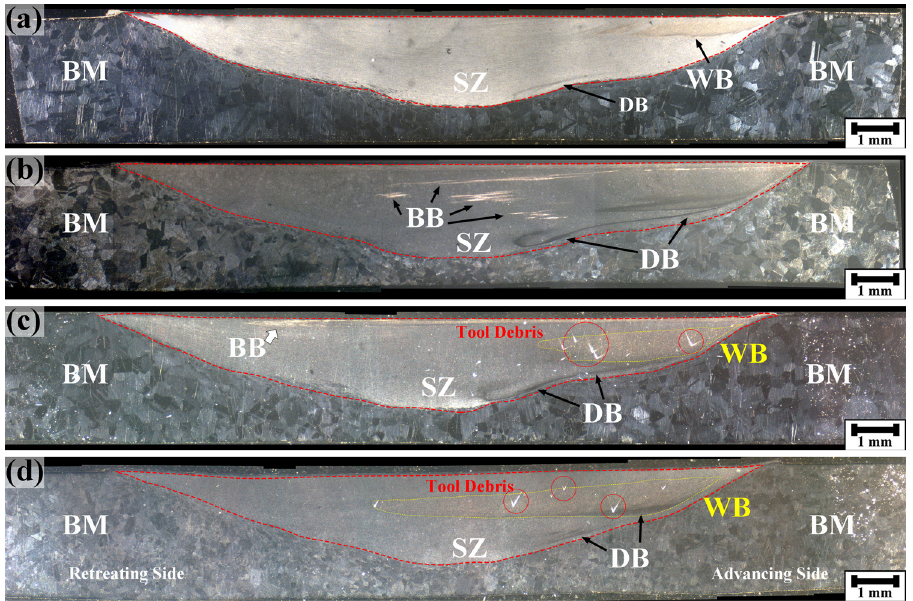
Figure 5: Cross - sectional macrostructure of the welds at rotational speed of ( a ) 200, ( b ) 300, ( c ) 400, and ( d ) 500